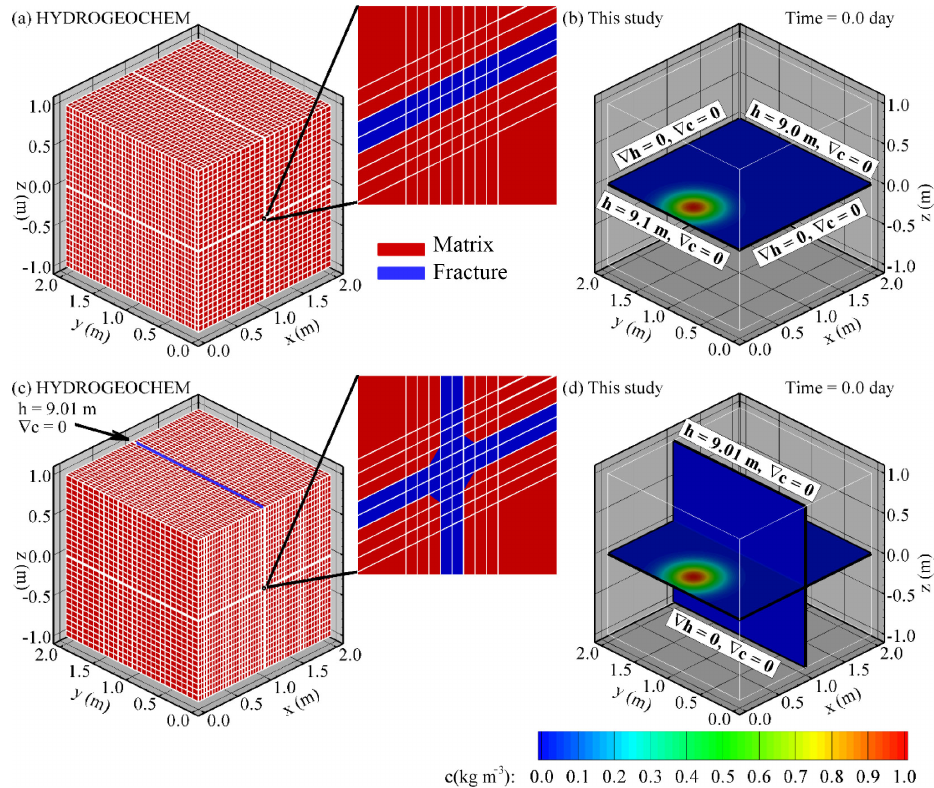
Figure 3. Conceptual model for the verification of a 2-D horizontal fracture plate and a cross-shaped fracture network: (a) the mesh of HYDROGEOCHEM model for the horizontal fracture plate, (b) the DFN conceptual model for the horizontal porous fracture, (c) the mesh of HYDROGEOCHEM model for the cross-shaped fracture network, and (d) the DFN conceptual model for the cross-shaped fracture network. Note that the single fracture plate (i.e., a ) and cross-shaped fracture network (i.e., c ) in the HYDROGEOCHEM model are represented with the relatively high hydraulic conductivity (i.e., 1.0md − 1 ). However, the hydraulic conductivity for the matrix in HYDROGEOCHEM model was assumed to be 10 − 5 md − 1